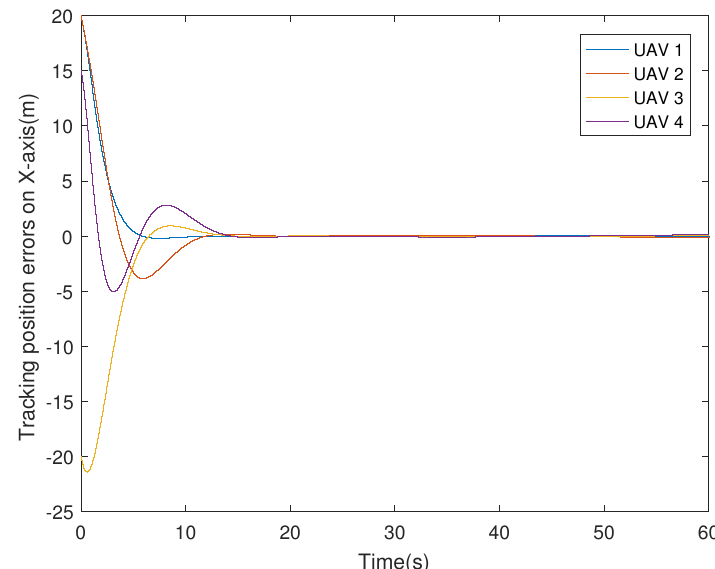
Figure 3. Responses of Ψ ix on